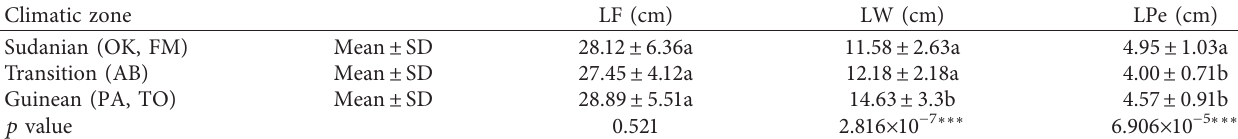
Table 8: Mean values of leaf parameters according to the climatic zone.